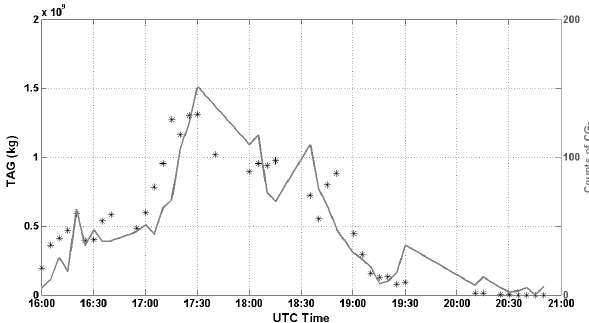
Figure 9. The time evolution of TAG (black stars and y axis on the left side) and the − CG stroke counts (solid line and y axis on the right side) that occurred on 15 October 2012 within the Polar 55C coverage area.